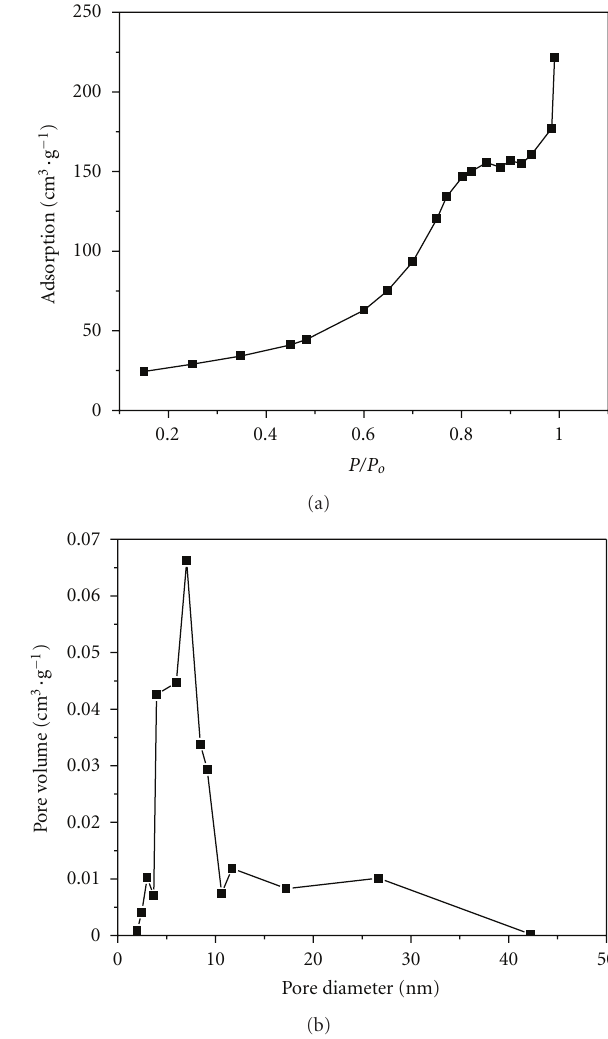
Figure 5: N 2 desorption isotherms (a) and pore size distribution (b) of mesoporous TiO 2 -Al 2 O 3 binary oxides prepared at C PEG1000 = 0.03